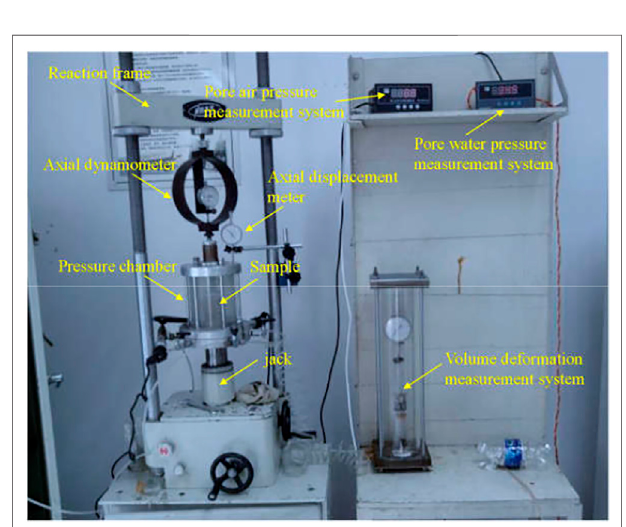
FIGURE 3 | Apparatus of consolidated undrained triaxial